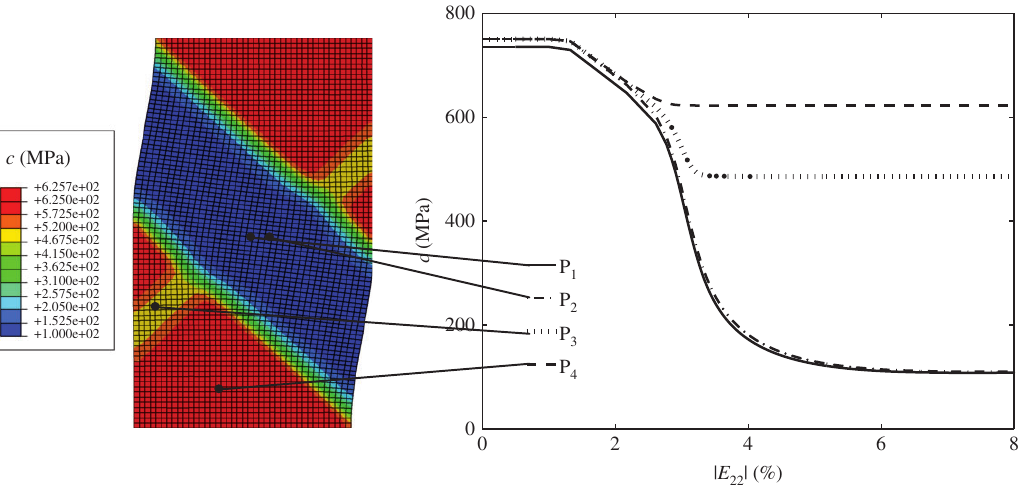
Figure 8 Sample S , general model behavior: cohesion c over applied strain | E 1 mesh that shows the cohesion distribution c at | E P , element within shear band and with initial defect; P 1 outside localized